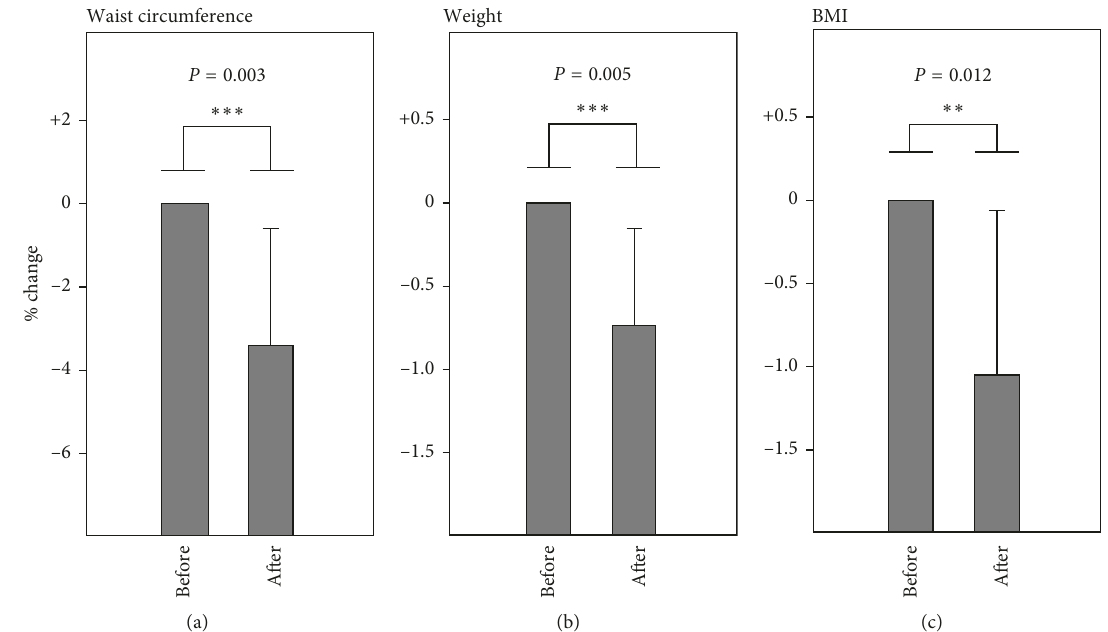
Figure 3: Decrement in (a) waist circumference, (b) weight, and (c) BMI following three sequential daily applications of tissue cryotherapy. Error bars indicate SD; error bars are not shown for the left-hand plots in each panel because these were normalized to 100%.